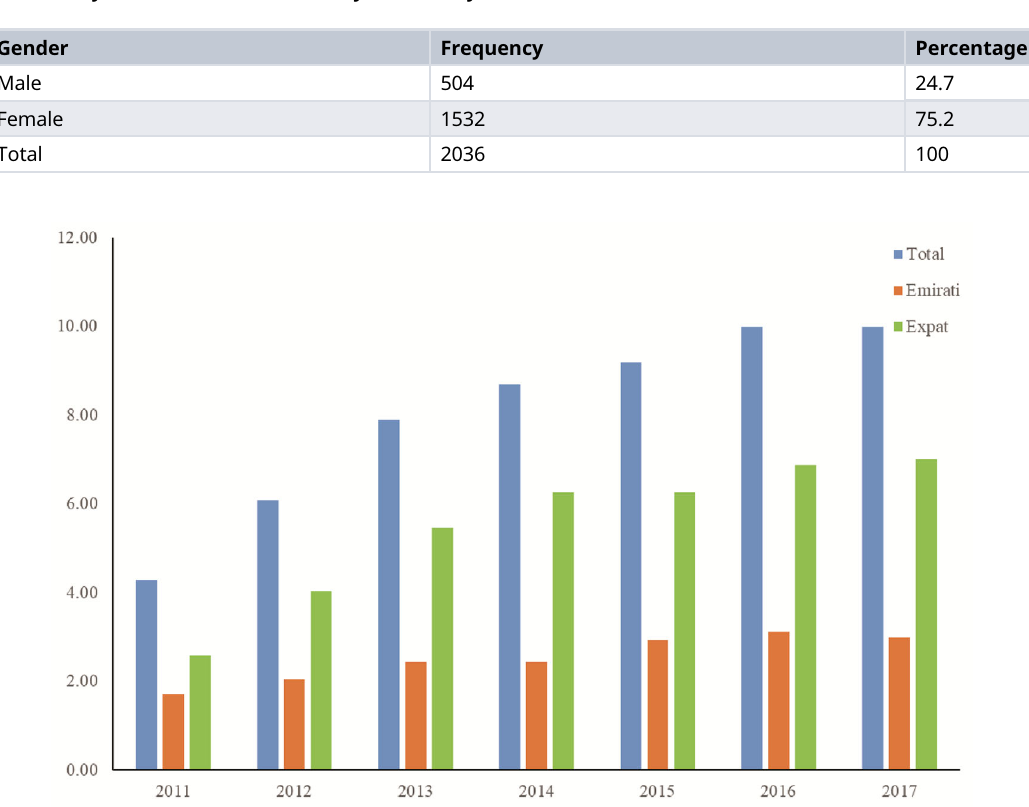
Table 5. Thyroid cancer distribution by nationality in the UAE from 2011 to